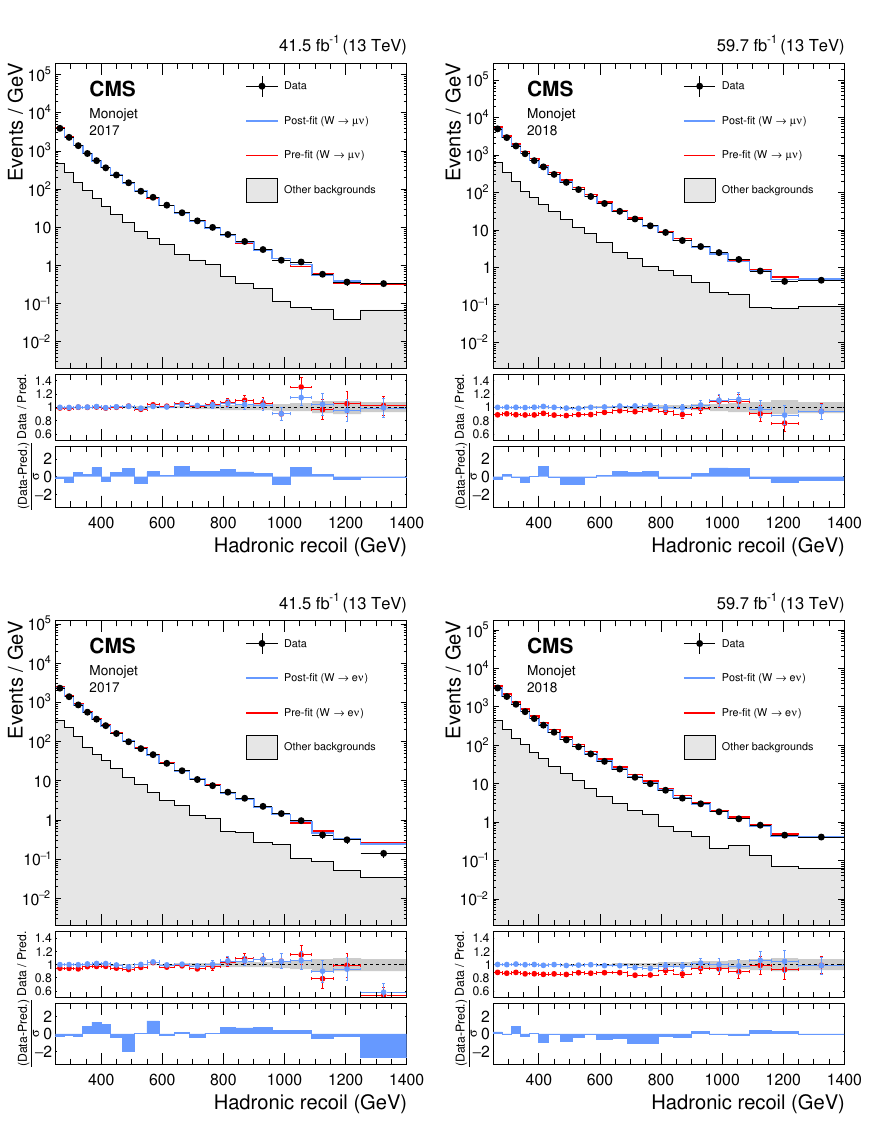
Figure 14 . Hadronic recoil distributions in the single muon (upper), and single electron regions (lower) in the monojet category. The “Other backgrounds” include top quark, diboson, and QCD multijet